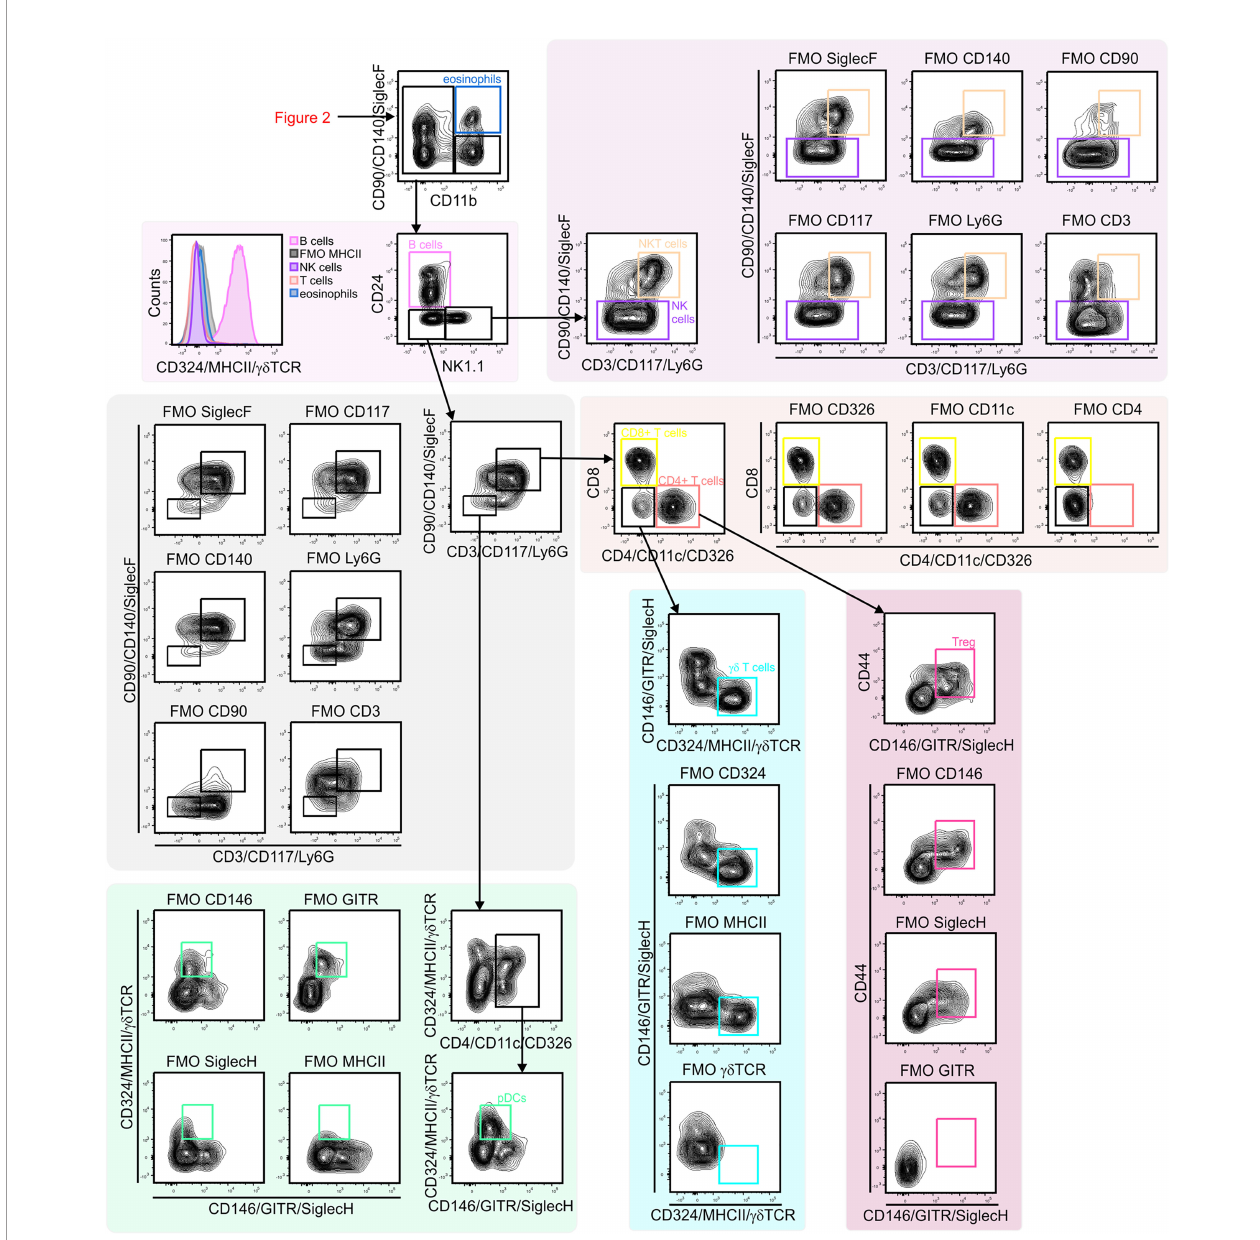
FIGURE 3 | Gating strategy for lung lymphoid cells. CD11b – lymphocytes were fi rst separated based on CD24 and NK1.1 expression to identify B cells (CD24 + / MHCII + ) and NK1.1 single positive cell (CD24 – /NK1.1 + ). NK1.1 + population contained CD3 – NK cells and CD3 + /CD90 + NKT cells. CD24 – /NK1.1 – population included CD3 + T cell subsets (CD4 + T cells, CD8 + T cells, Treg cells (CD4 + /GITR – ) and gd T cells ( gd TCR + /CD4 – /CD8 – ). Within CD3 – cells pDCs (CD11c + /MHCII + SiglecH + ) were identi fi ed. NK, natural killer; NKT cell, natural killer T cell; pDC, plasmacytoid dendritic